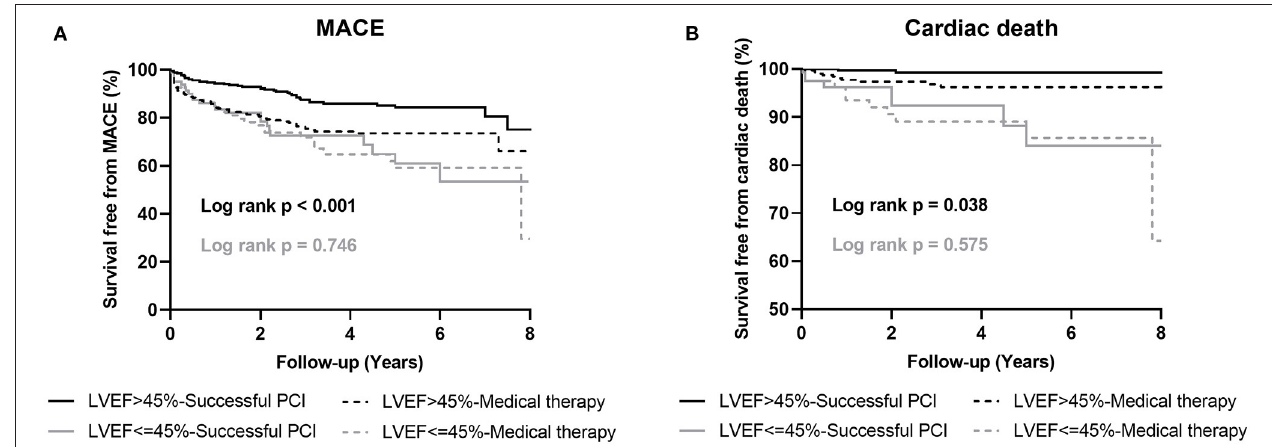
FIGURE 2 | Kaplan-Meier curves for MACE (A) and cardiac death (B) during follow-up for successful CTO-PCI vs. medical therapy in propensity-matched patients with and without left ventricular systolic dysfunction. LVEF, left ventricular ejection fraction; MACE, major adverse cardiovascular events; PCI, percutaneous coronary